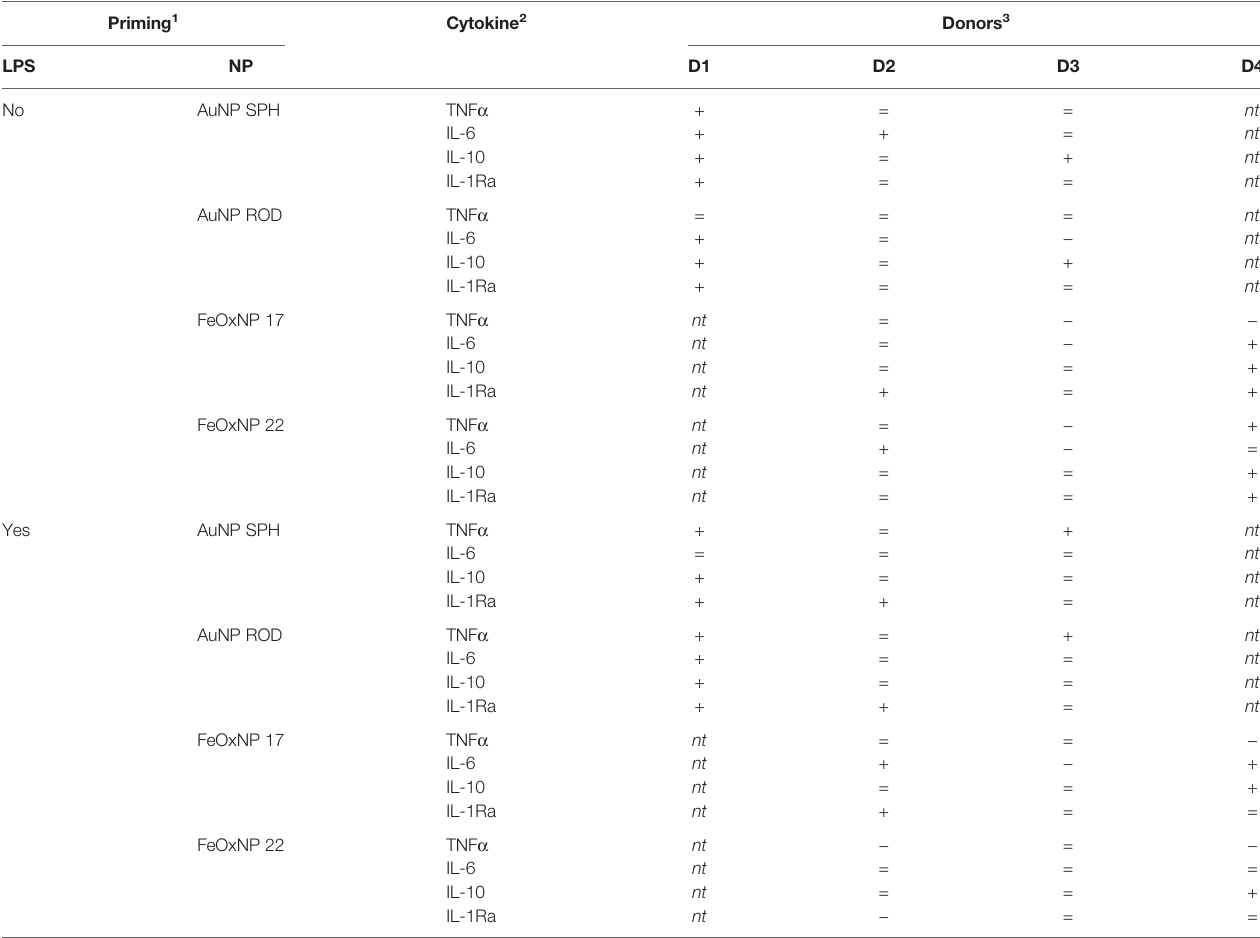
TABLE 3 | Changes in cytokine production in NP-induced innate memory